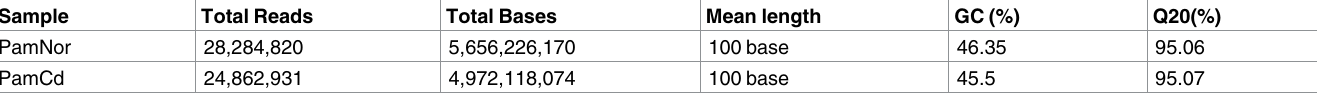
Table 2. Sequencing results of the P . americana transcripts with (PamCd) and without (PamNor) Cd treatment. Sample Total Reads